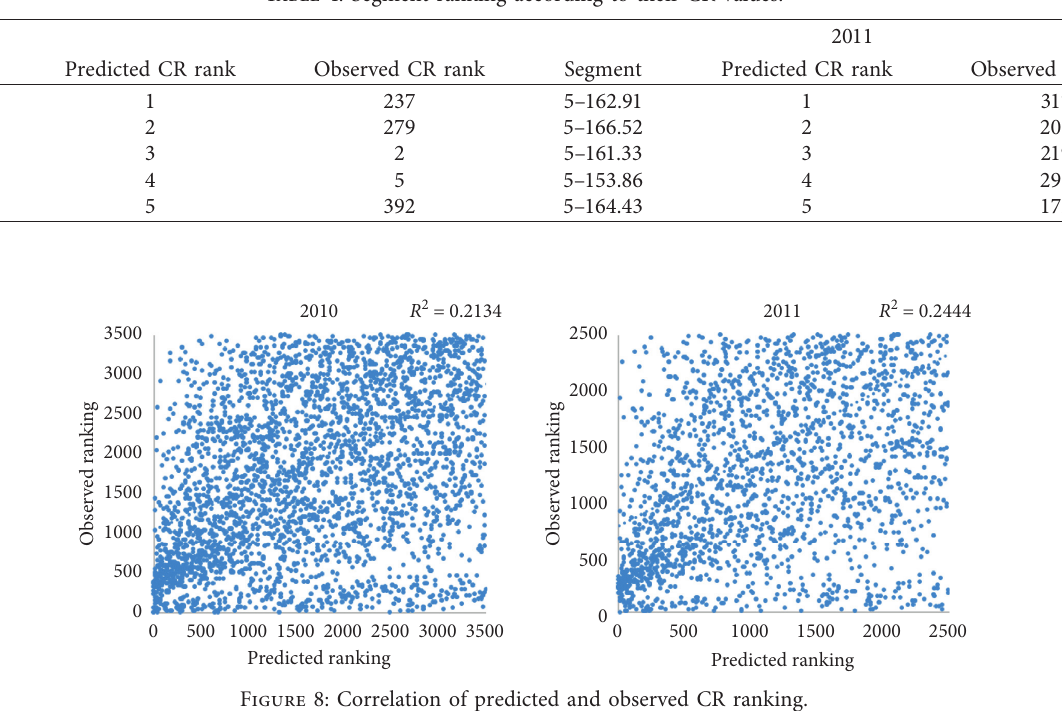
Table 4: Segment ranking according to their CR values.